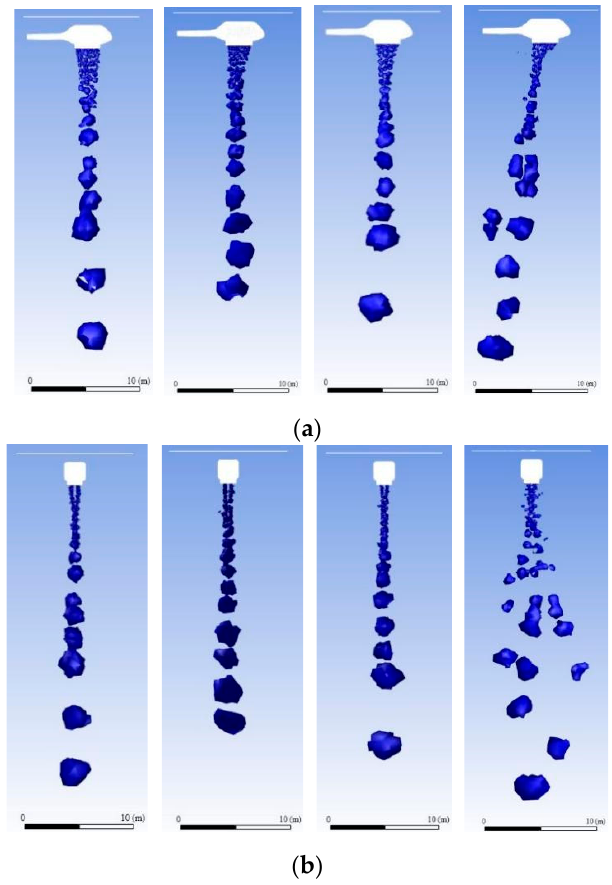
Figure 26. Contour surface of the two-phase, water–air interface at a volume fraction of 0.01 under different wind speeds ( H = 30 m; the ground is at the ruler in the figure; t = 2.1 s). ( a ) Front view, showing U = 0 m/s, 5 m/s, 10 m/s, and 15 m/s, respectively, from left to right. ( b ) Front view, portraying U = 0 m/s, 5 m/s, 10 m/s, and 15 m/s, respectively, from left to right.